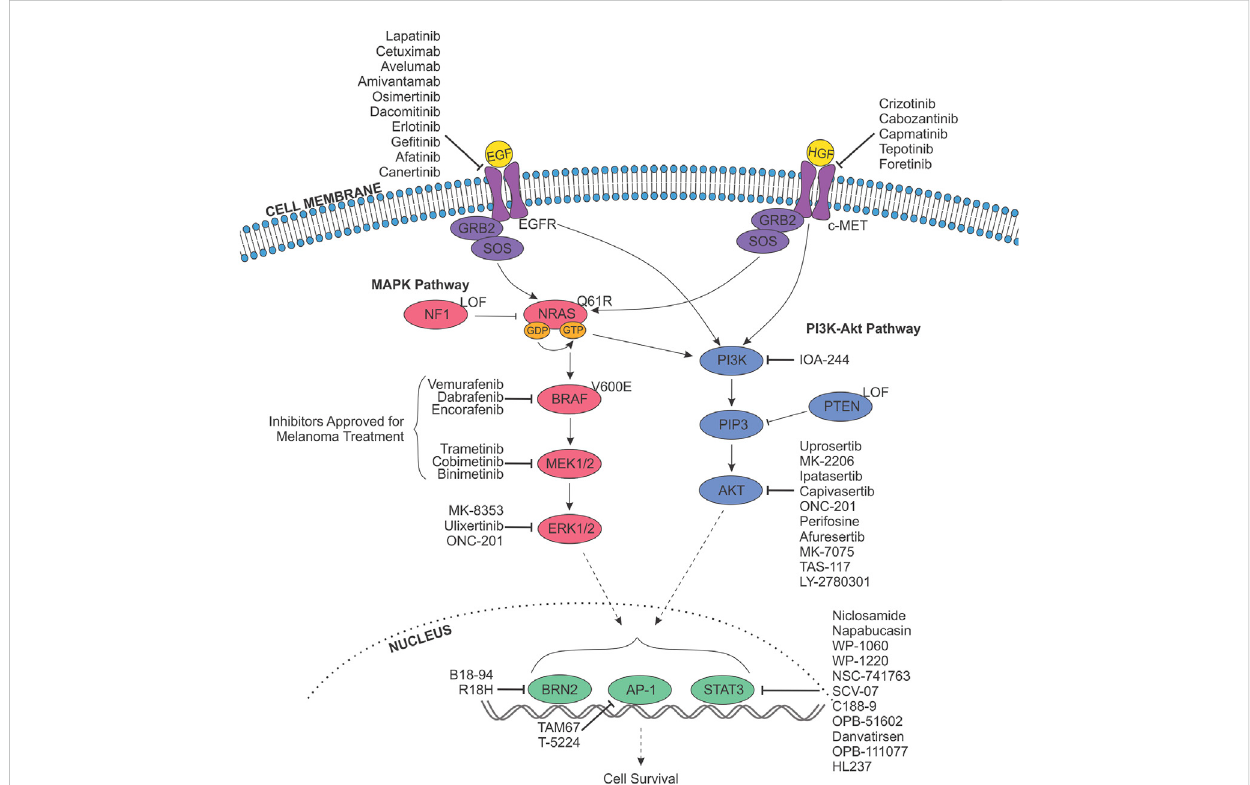
FIGURE 4 Targeting receptor tyrosine kinase signalling pathways in melanoma anoikis resistance. The MAPK (pink) and PI3K-Akt (purple) signalling pathways are constitutively activated in melanoma and stimulated by the binding of a growth factor (Epidermal Growth Factor (EGF)/Hepatocyte Growth Factor (HGF); yellow) to their respective receptor tyrosine kinase at the cell membrane (EGFR/c-MET). Oncogenic activation of these pathways is due to one of three proteins, whose genes are mutated with high frequently in melanoma; BRAF, NRAS and NF1. Most commonly, the BRAF gene harbours a mutation resulting in the V600E alteration, while NRAS usually possesses mutations leading to the Q61R variant, and NF1 is frequently effected by a genetic alteration resulting in loss of function (LOF). These variations result in abnormal signalling to downstream effectors, resulting in altered proliferation, differentiation, apoptosis, cell survival and metabolism; inevitably driving melanoma initiation and progression. As such, components of the MAPK pathway are targeted with small molecule inhibitors for the therapeutic treatment of melanoma, and have been approved as either single-agent therapies or in combination. Inhibitors approved for treatment of melanoma are indicated. In addition, inhibitors targeting EGFR, c-MET, the PI3K-Akt pathway, and downstream transcription factors (green) exist, and have the potential to block anoikis resistance. Indicated inhibitors have been sourced from data from all